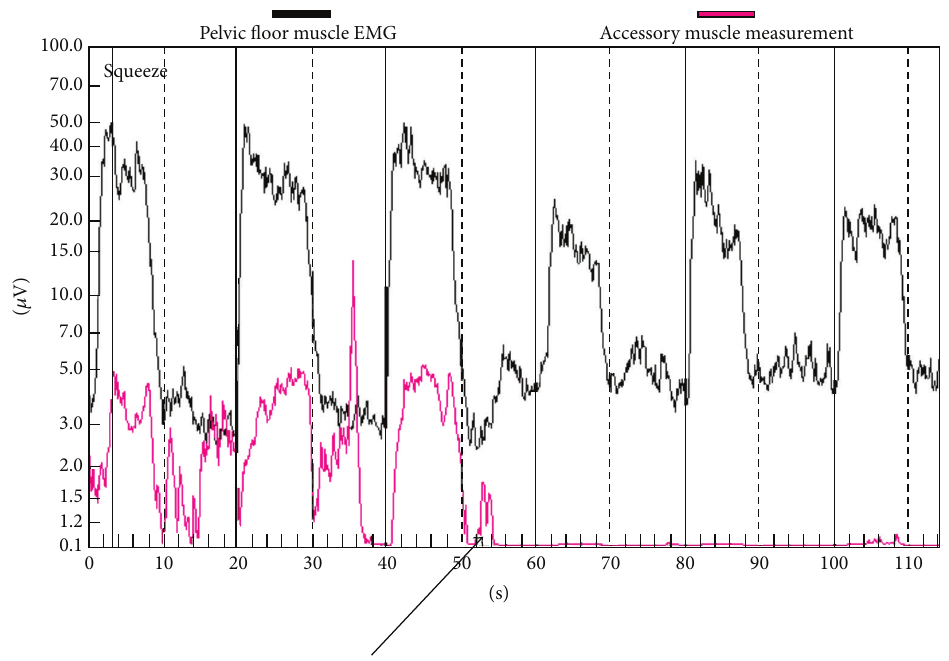
Figure 2: Discrimination training. The electromyographic tracings of a patient with postprostatectomy urinary incontinence showing accessory muscle hyperactivity (pink) during pelvic floor muscle contractions. The accessory muscle electrical activity is entirely suppressed following successful patient sensory awareness training